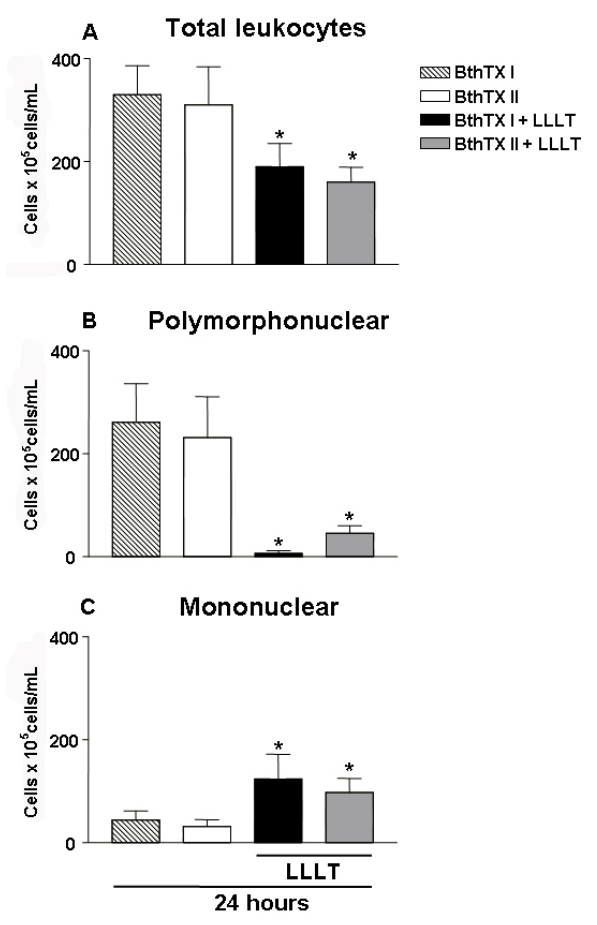
Figure 3 . Myonecrosis in gastrocnemius muscle induced by BthTX-I or BthTX-II and LLLT treatment. Saline solution in contralateral muscle (horizontal striped bar), BthTX-I (gray bar), BthTX-I + LLLT (empty bar), BthTX-II (black bar) and BthTX-II + LLLT (diagonally striped bar). * p < 0.05 versus the corresponding myotoxin